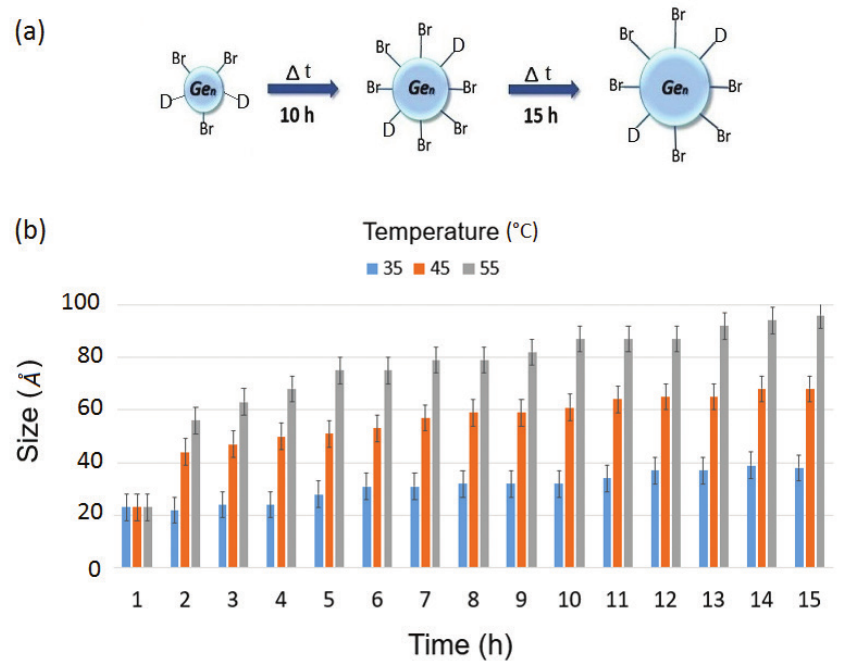
)). (b) Time dependence of the size evolution of the GeNP during the 3